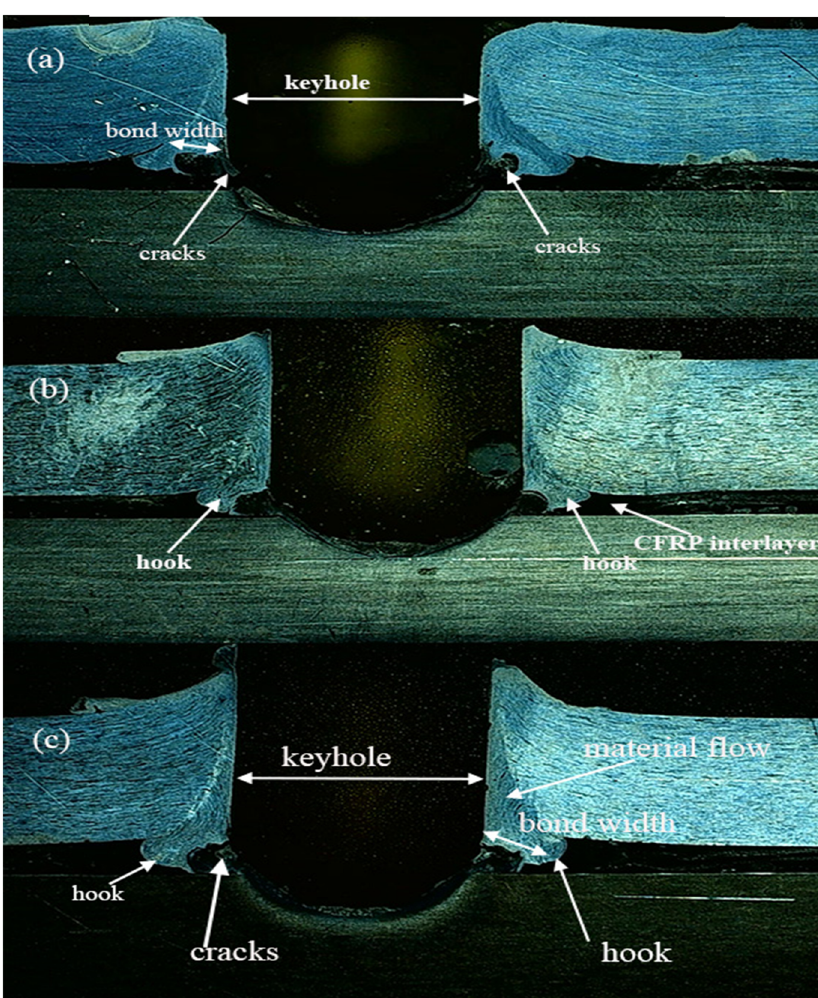
Figure 6: Cross - sectional view of FSSW joint with carbon fi ber ( a ) 1,000 rpm and 5 s dwell time, ( b ) 1,400 rpm and 10 s dwell time, and ( c ) 1,400 rpm and 5 s dwell